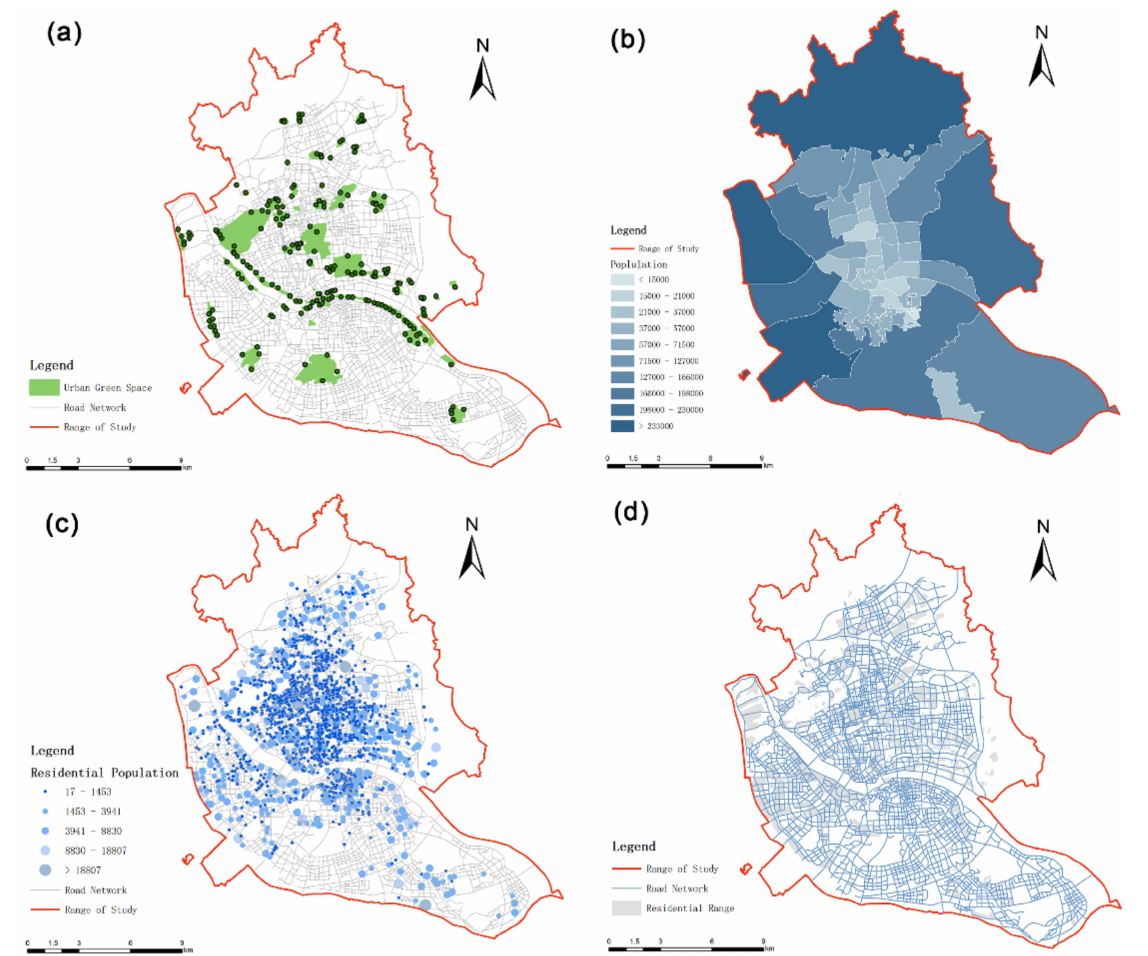
Figure 2. ( a ) Distribution of UGS in the study area. ( b ) Population distribution in sub-district scale. Information on the road network in the study area. ( c ) Population distribution in residential scale. ( d ) Information on the road network in the study